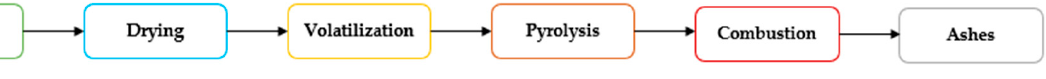
Figure 3. Biomass combustion